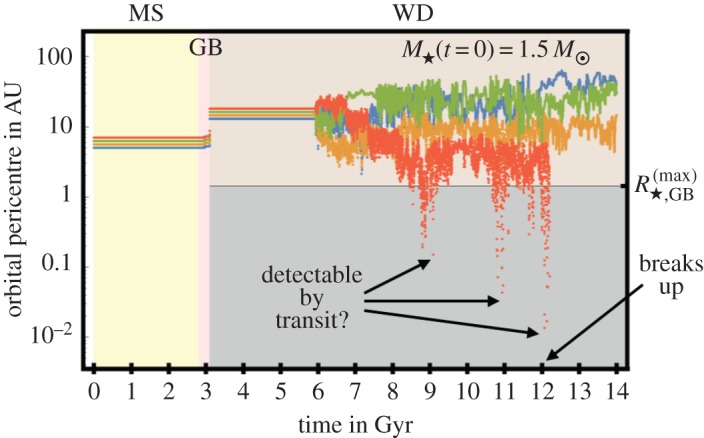
Cosmetically enhanced version of the upper-left panel of fig. 1 of [144]. Late unpacking of four tightly-packed terrestrial planets throughout the MS and GB phases. The orbit meandering which follows scattering instability perturbs the red planet into a likely transit-detectable orbit before it enters the WD disruption radius.